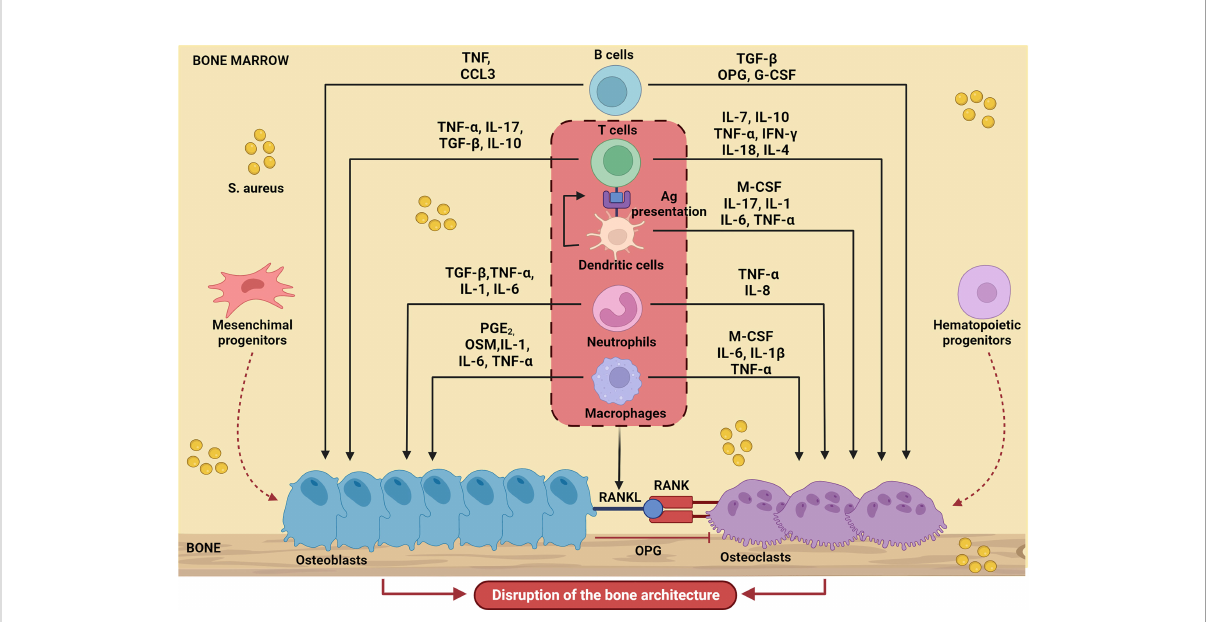
FIGURE 1 Schematic representation of bone cell regulation by the main soluble factors produced by immune cells during S. aureus-induced osteomyelitis. Upon infection, immune cells migrate into the bone microenvironment and release cytokines (IL-17, IL-10, IL-1, IL-1 b , IL-6, IL-7, IL-18, IL-4, IL- 8), chemokines (CCL3), growth factors (M-CSF, G-CSF) and other several in fl ammatory mediators (TNF- a , PGE 2 , TGF b , INF- g , OSM) that in fl uence osteoblast and osteoclast activity. The result is massive disruption of the normal bone architecture. The Figure was created with